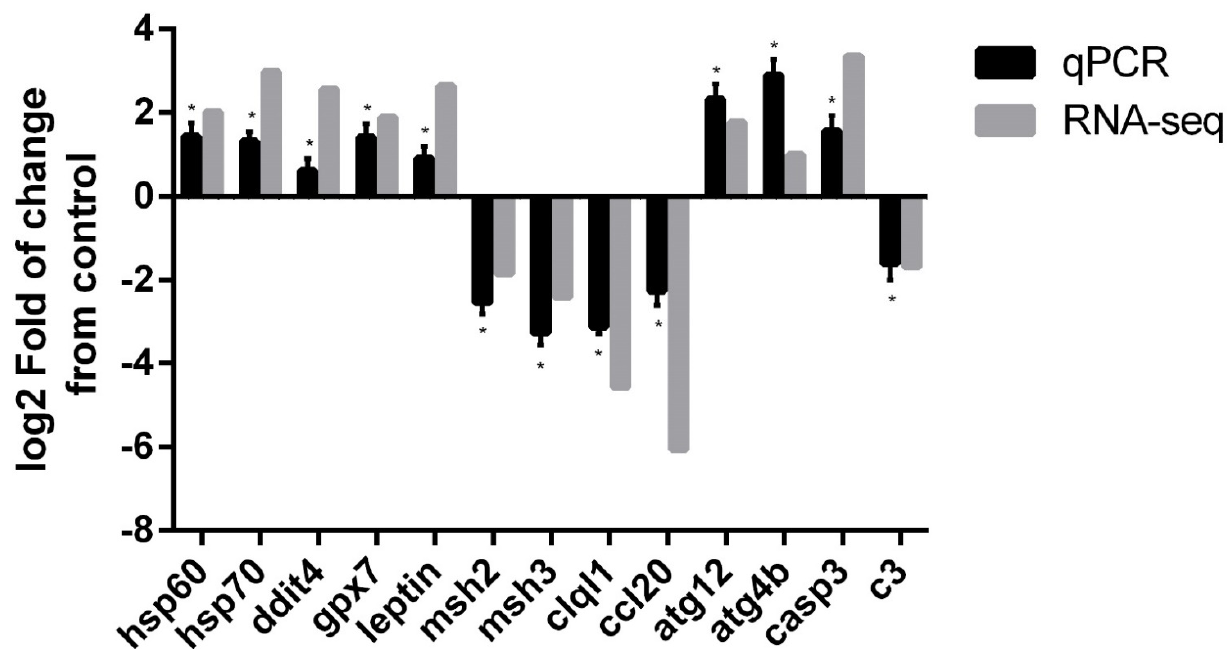
Figure 5. qPCR validation of selected differentially expressed transcripts in the liver of G. chilensis in response to high-temperature stress. The transcript expression levels were normalized with the geometric means of actb and taf12 . The differential expression levels according to qPCR (black bars) and RNA-seq (gray bars) for these selected genes are expressed as log 2 fold changes. The log 2 FC represents the expression change in the stress group compared with the control group. Results are expressed as the mean ± standard error. Significant differences in the validated qPCR data between control and stress groups are indicated by asterisks in the log2 Fold qPCR bars; (* p -value < 0.05).